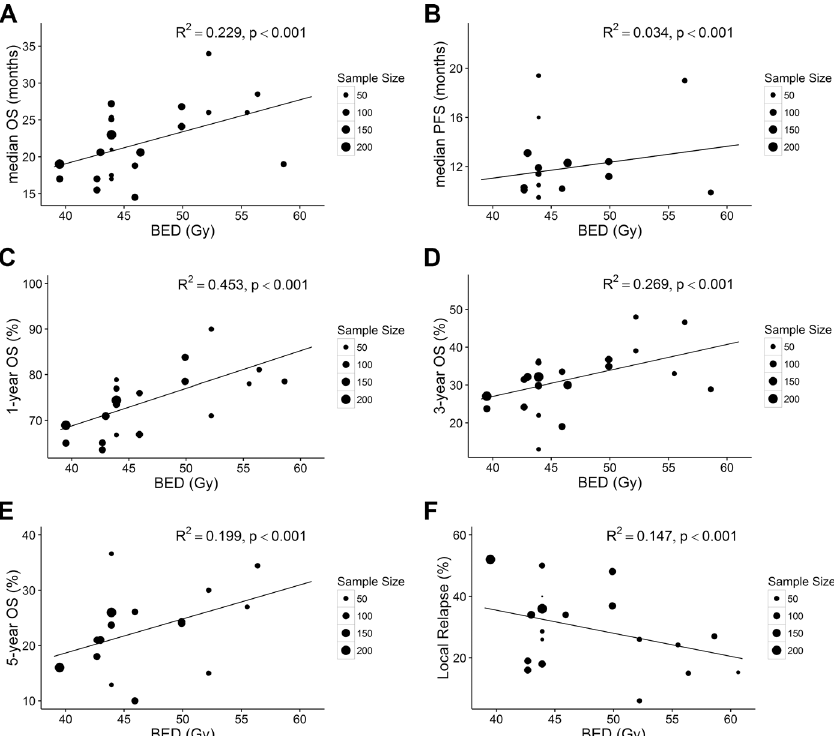
Fig 3. Association between BED and mOS (A), mPFS (B), 1-year OS (C), 3-year OS (D), 5-year OS (E), and LR (F) in the setting of concurrent chemo-radiotherapy. Each point in the plot represents a value of one arm. The point size represents the sample size. All analyses were conducted by linear regression methods weighted by sample size. BED , biological effective dose; mOS , median overall survival; 1-, 3-, 5-year OS , 1-, 3, 5-year overall survival; LR , local relapse